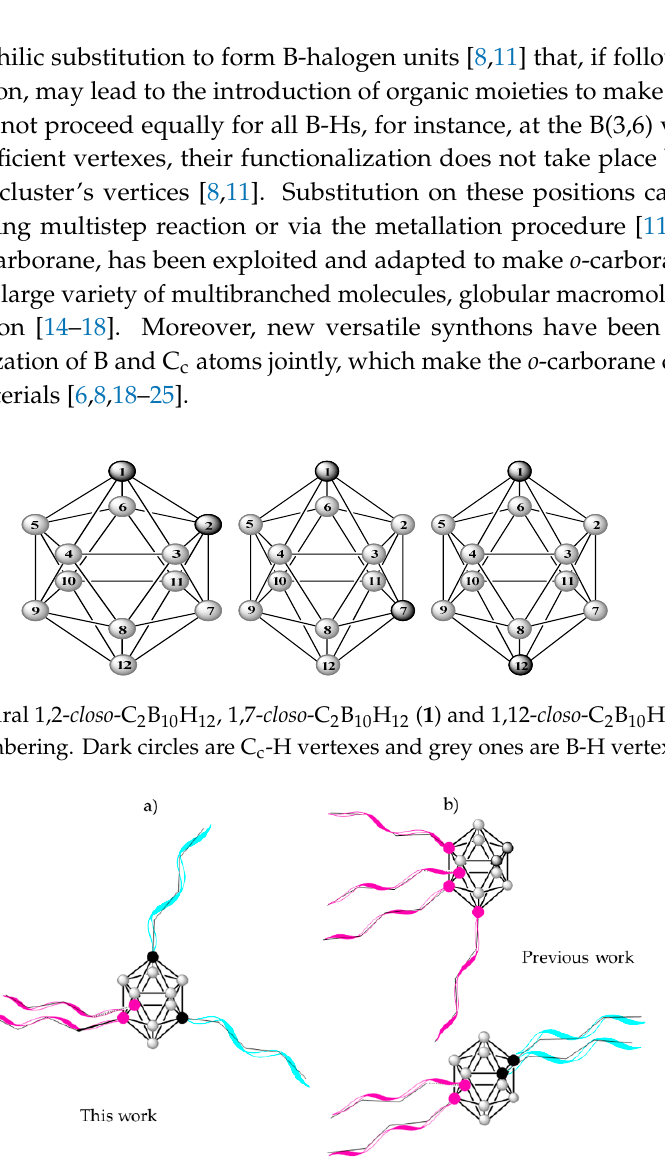
Figure 2. Schematic view of the two types of radially expanded tetrabranched core for constructing dendritic structures. Circles colour: dark grey correspond to C c -H bonds, black to C atoms, pink to Boron atoms and grey to B-H vertexes in the tetra-branched clusters.